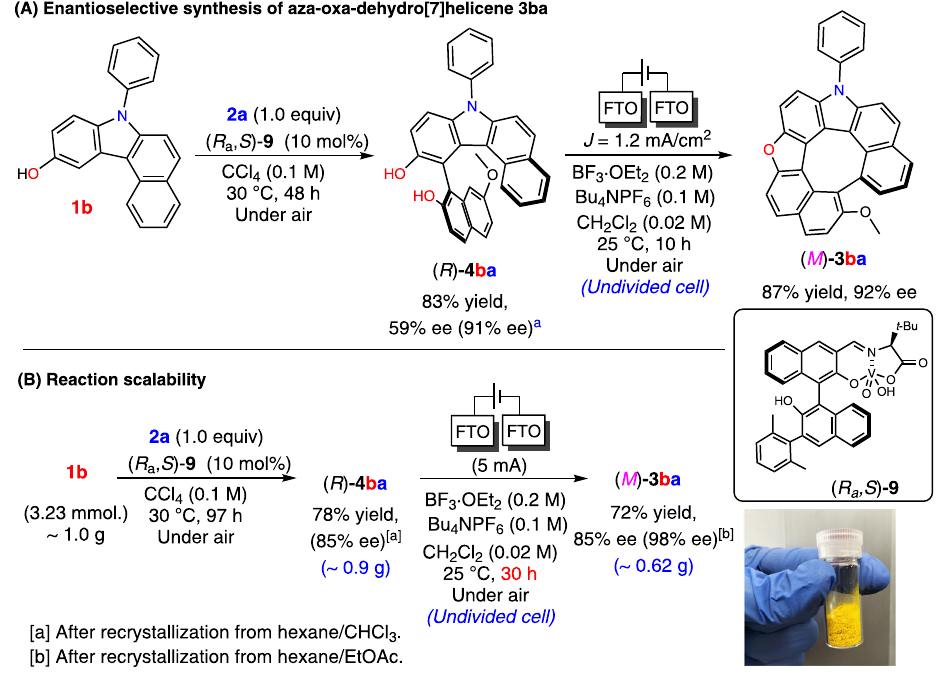
Fig. 5 Stepwise enantioselective synthesis of aza-oxa-dehydro[7]helicene 3ba, and veri fi cation of the reaction scalability. A Stepwise enantioselective synthesis of dehydrohelicene ( M )- 3ba using hybrid vanadium and electrochemistry. B Scaling up the enantioselective synthesis to semi-gram